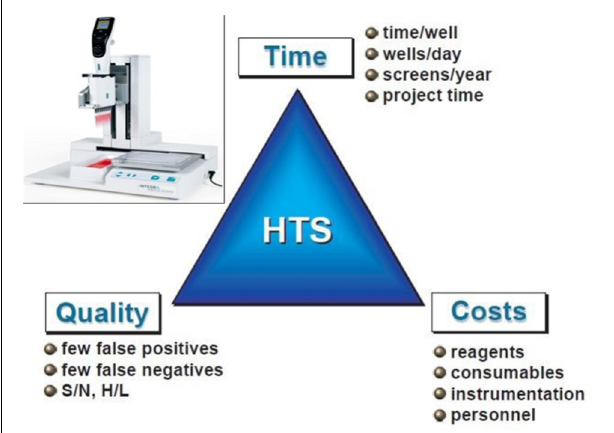
FIGURE 11 | The keys to successful high-throughput screening (HTS). Optimization of screening systems is evaluated according to 3 criteria: time, cost, and quality. S/N, signal-to-noise ratio; H/L, High-to-low ratio (sensitivity of the screening; adapted from Mayr and Fuerst, 2008)